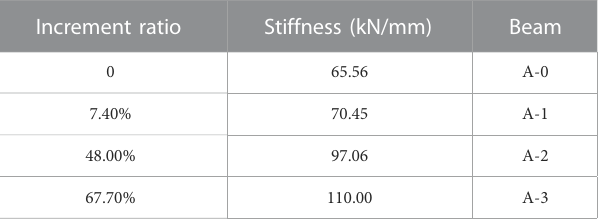
TABLE 7 Initial stiffness for the tested beams (a/d = 1.5).